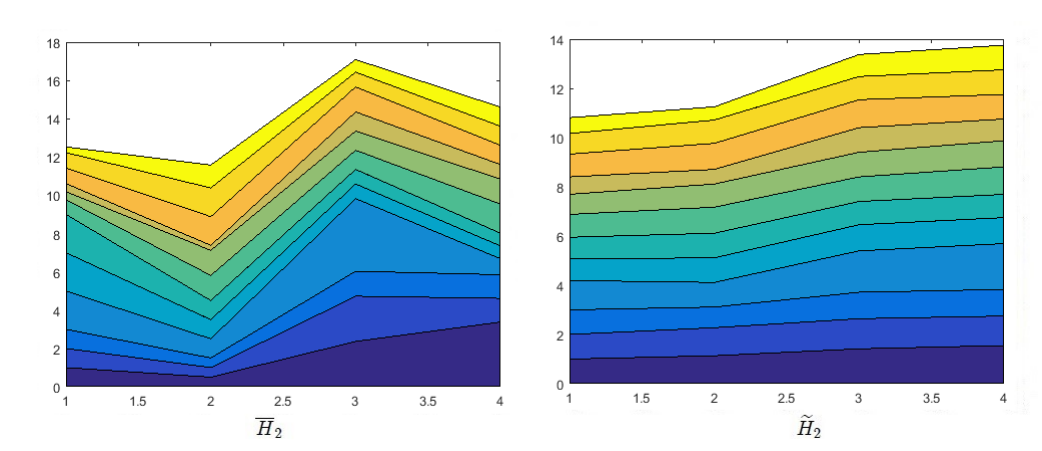
Figure 6. Area graphs of score values for H 2